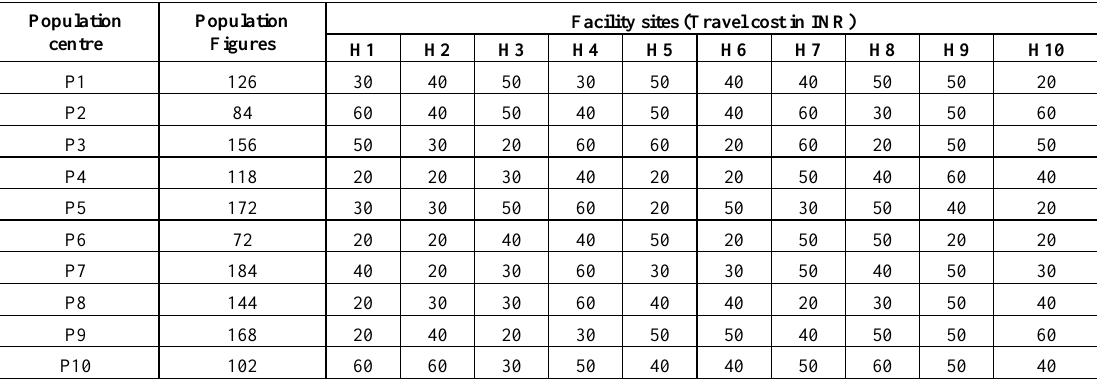
Table 1. Population and travel cost